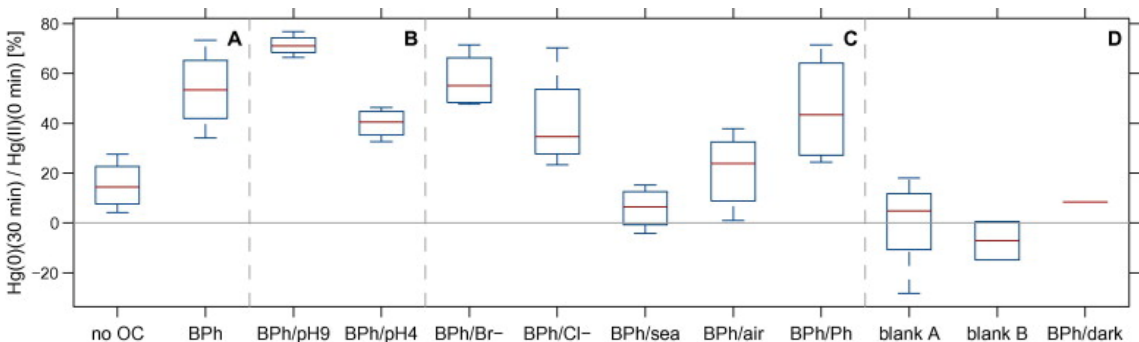
Fig. 17. The effect of a different chemical composition of the ice matrix on the photochemistry of mercury during 30 min irradiation with UVA at 258K (sectors A − C). Also, blank experiments in the dark are shown for comparison (sector D). The solution to freeze the ice films was always doped with Hg(II) (6 × 10 8 M) and additionally contained the following compounds as indicated: “no OC” denotes experiments of pure HgO solutions; “BPh” of 6 × 10 7 M benzophenone in unbuffered solutions at pH 7 (of the molten ice film); “BPh/pH 9” and “Ph/pH4” NaOH and H 2 SO 4 added to 6 × 10 7 M benzophenone to reach a pH of 9 or of 4, respectively; “Ph/Br − ” 6 × 10 7 M benzophenone and 5 × 10 8 M bromide; “BPh/Cl − ” 7 × 10 8 M chloride, “BPh/sea” 0.5 M chloride, 1mM bromide; “BPh/air” 6 × 10 7 M benzophenone in the ice, 20% oxygen present in the carrier gas stream; “BPh/Ph” 5 × 10 7 M benzophenone and 6 × 10 8 M 2,6-dimethoxyphenol. In each box, the central mark is the median, the edges of the box are the 25th and 75th percentiles, and the whiskers extend to the most extreme data points. Reprinted with permission from Bartels-Rausch et al. (2011). Copyright (2011) Elsevier.